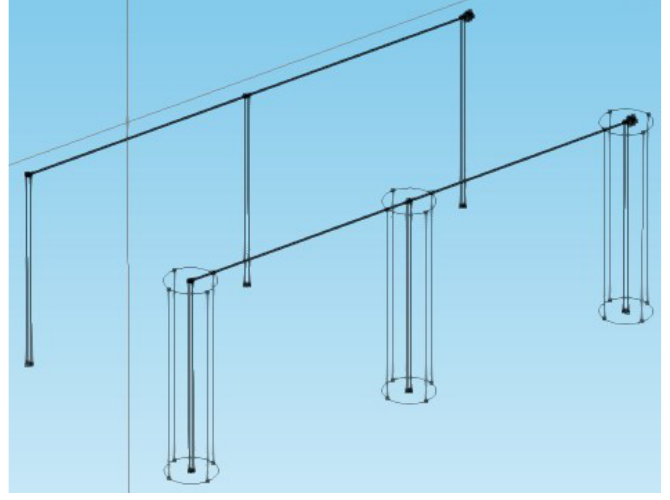
Fig. 5. Construction in FEM software of ground grid.